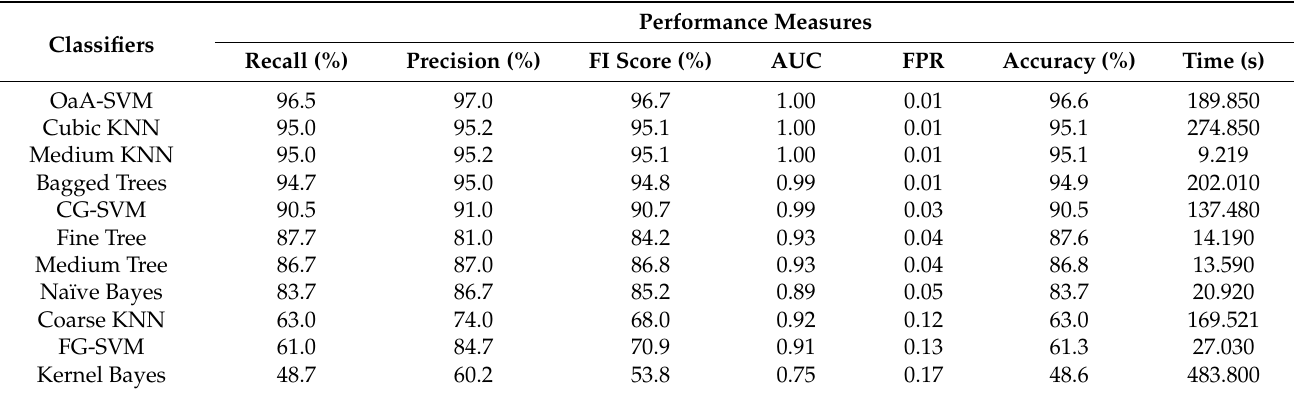
Table 2. Proposed gait-recognition results using real-time captured dataset for walking while carrying a bag at selected angles.